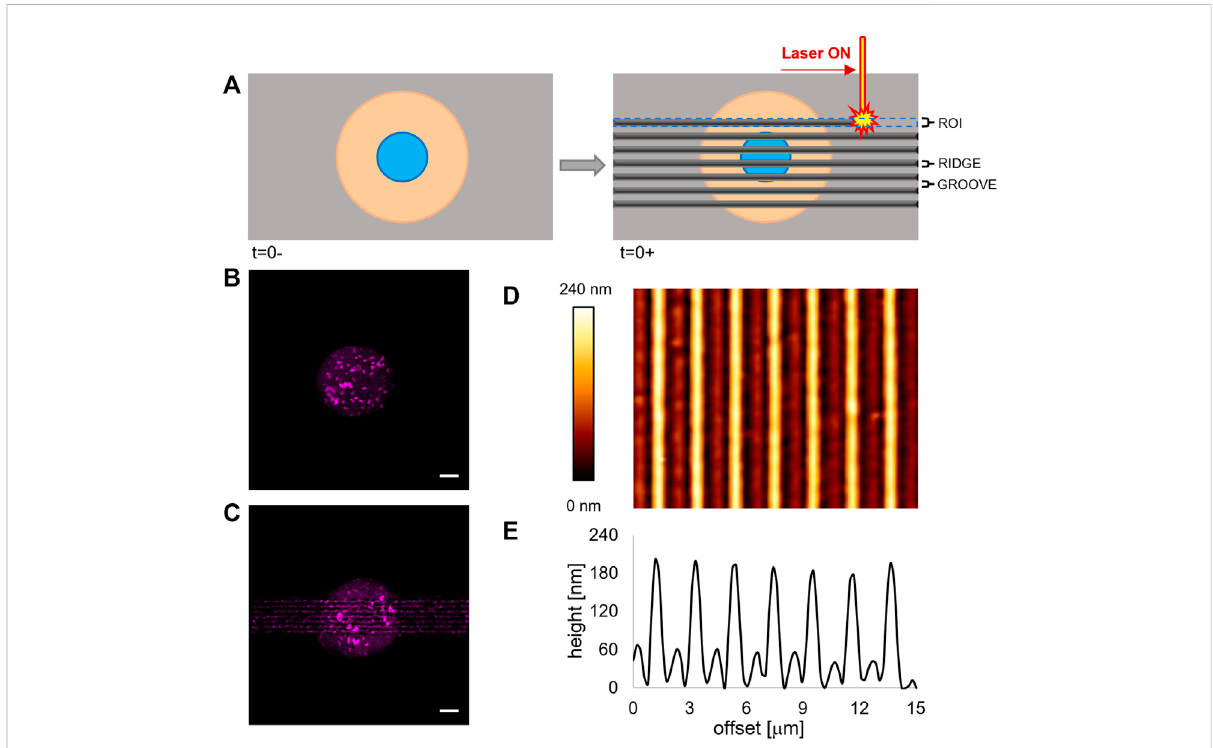
FIGURE 1 (A) Schematicrepresentationofthepatterningprocess via laserscanning. (B) Fluorescenceimagesofthemicropatterned fl uorescentlylabelled fi bronectin island on a fl at pDR1m substrate prior to pattern inscription and (C) on the same substrate after the inscription. Bar is 10 μ m. (D) AFM image of a pDR1m substrate displaying the laser-written topographic pattern. (E) Representative height pro fi le of a horizontal cross section of the topographic